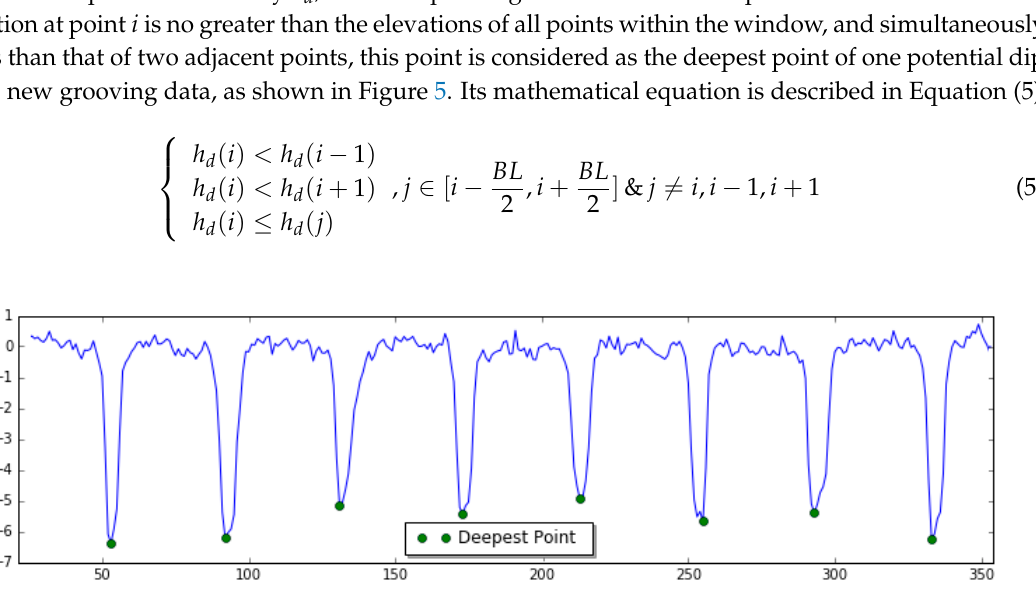
Figure 5. Determination of the deepest point inside dips.